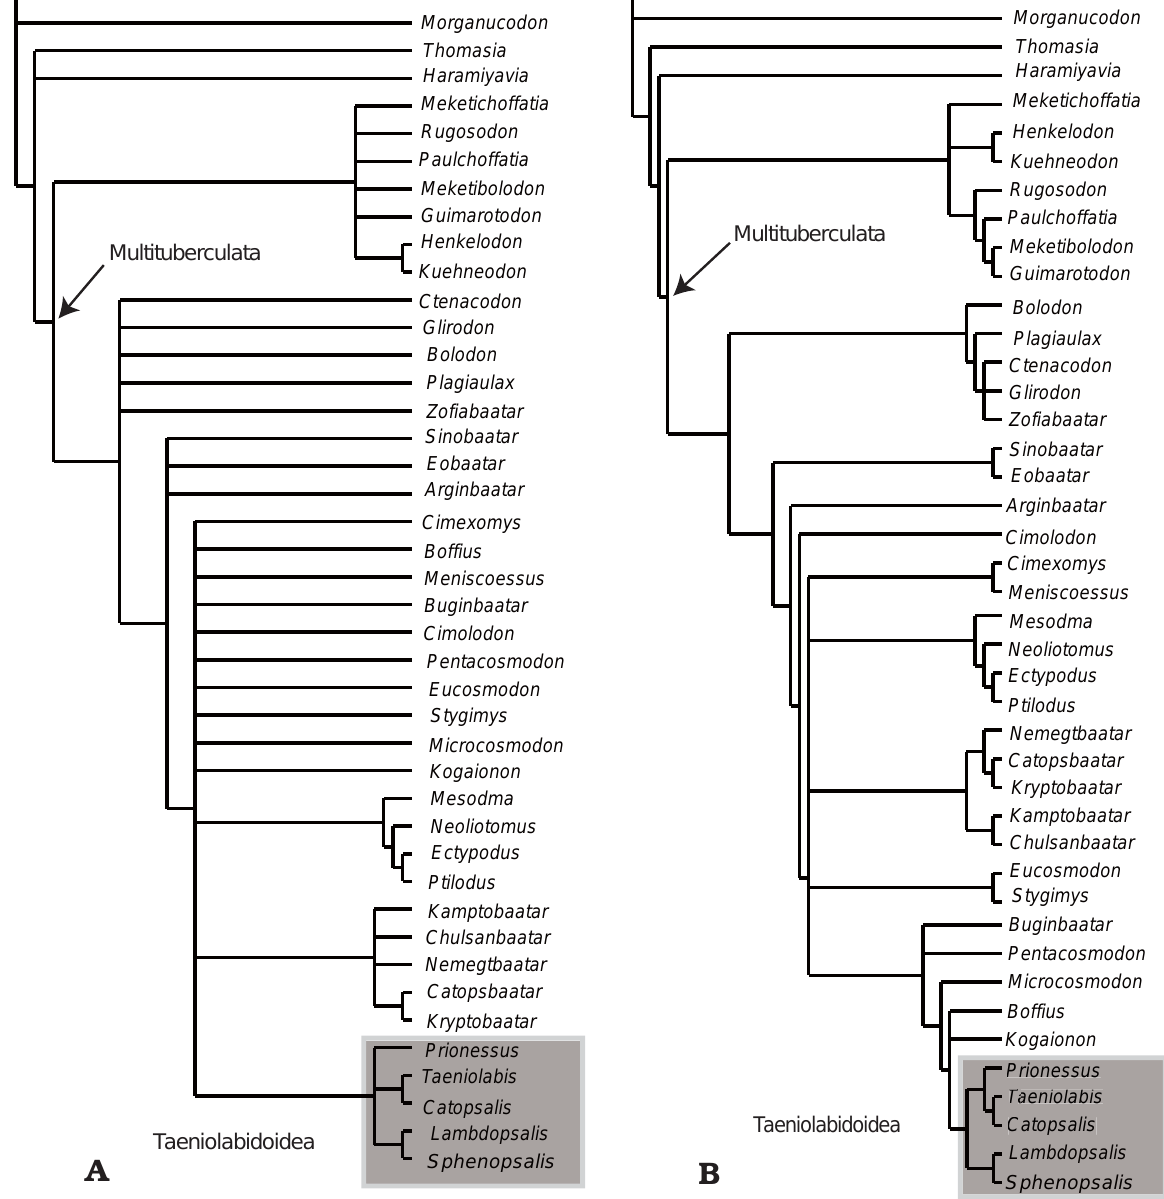
Fig. 16. Phylogenetic position of Sphenopsalis nobilis within multituberculates. A . The strict consensus tree of 70 most parsimonious trees obtained in the PAUP search where all characters were unordered. B . The 50% majority rule consensus tree with all characters unordered. See additional supporting data in the